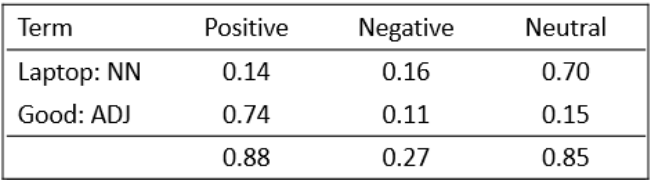
Figure 7. An example for subjectivity detection. DT: determiner; NN: noun; V: verb; ADJ: adjec- tive;